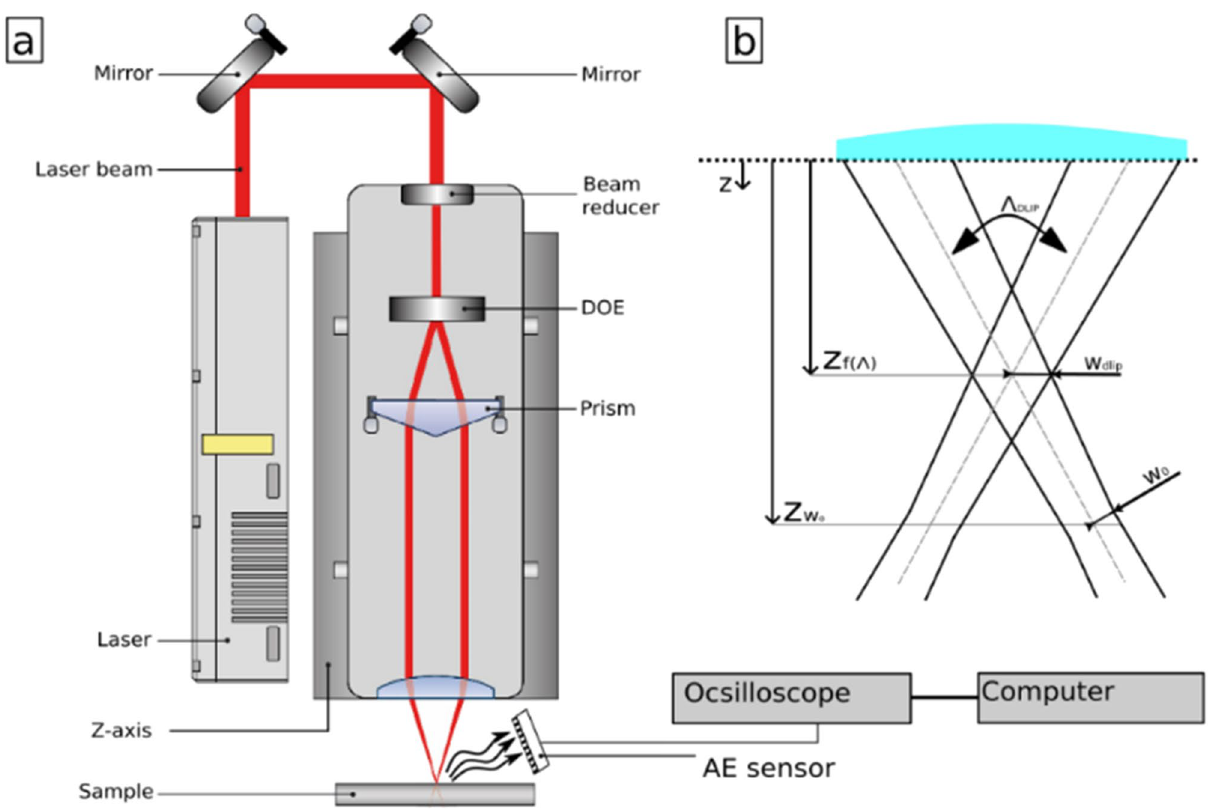
Figure 7. ( a ) DLIP setup with a laser system with the attached electret microphone (the microphone was placed on the back of the DLIP module so that both beams are symmetrical to the sensor), ( b ) Geometry of a DLIP